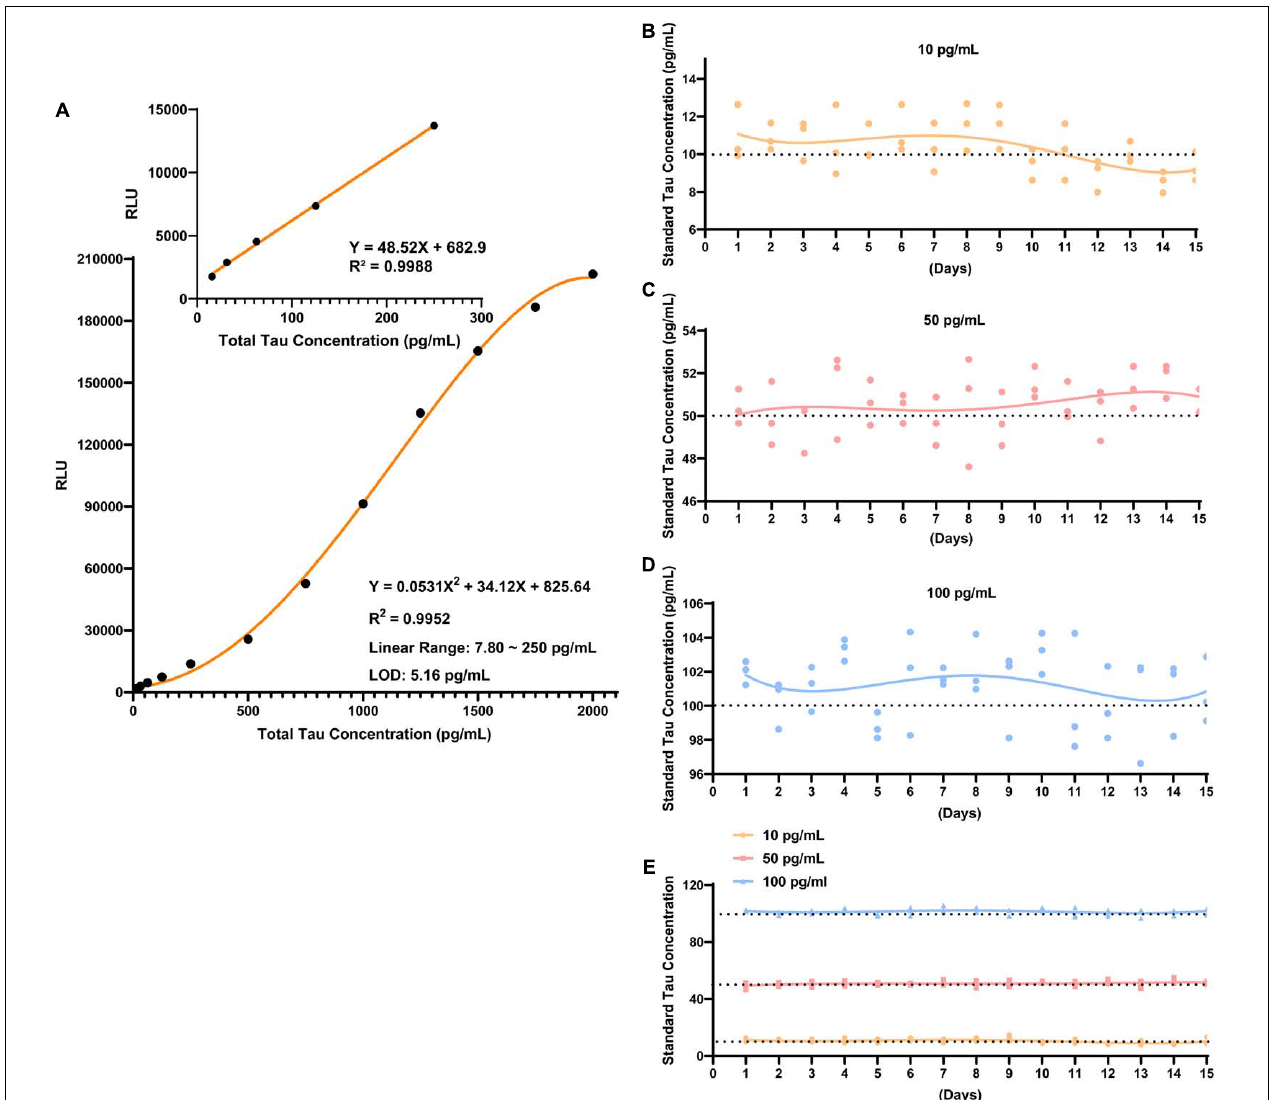
FIGURE 3 | The performance of CLIA for total Tau. (A) A quantification of total Tau using developed CLIA. The inset shows a dynamic linear range of Tau concentrations from 7.80 to 250 pg/mL. The repeatability was determined at three standard Tau concentrations: (B) 10 pg/mL; (C) 50 pg/mL; (D) 100 pg/mL. (E) Overall landscape of the three concentrations. The error bars expose the standard